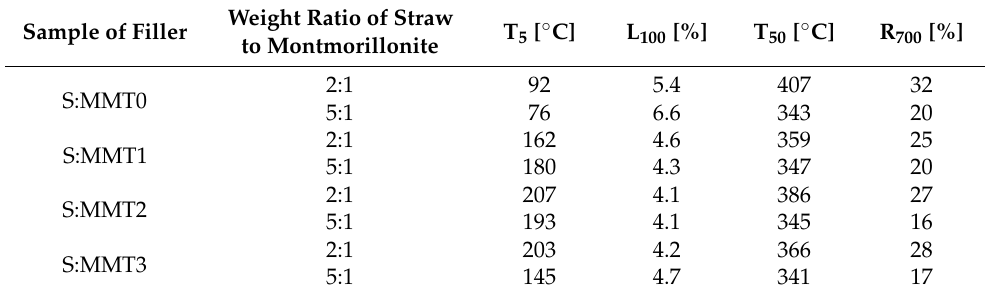
Table 2. Thermal parameters determined for biofillers: 5% (T 5 ) i 50% (T 50 ) weight loss temperature, weight loss of the sample at 100 ◦ C (L 100 ), residue at 700 ◦ C (R 700 ); standard deviations: T 5 ± 1 ◦ C, T 50 ± 2 ◦ C, L 100 ± 2%, R 700 ±